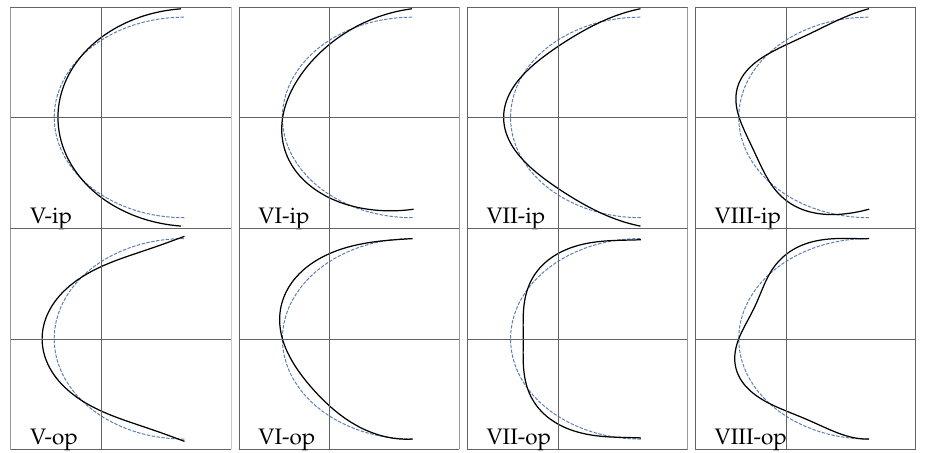
Figure 5. In-plane (ip) and out-of-plane (op) components of the trial functions, from V to VIII (deformation modes). Blue dashed line: initial configuration; black solid line: trial